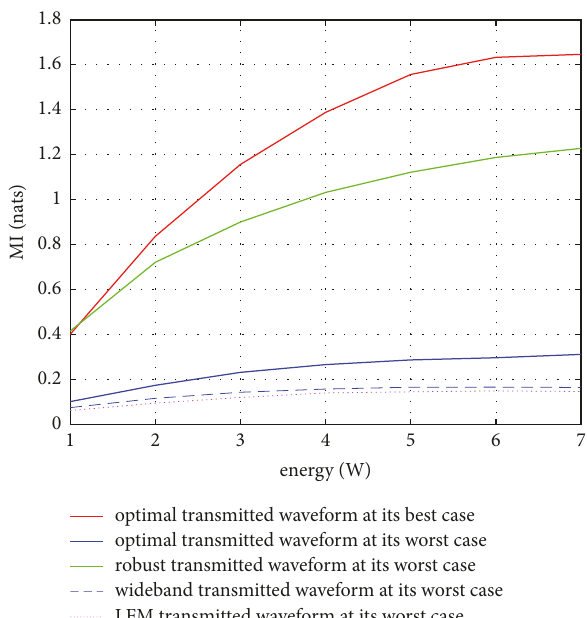
Figure 14: MI performance of the transmitted waveform results for multiple